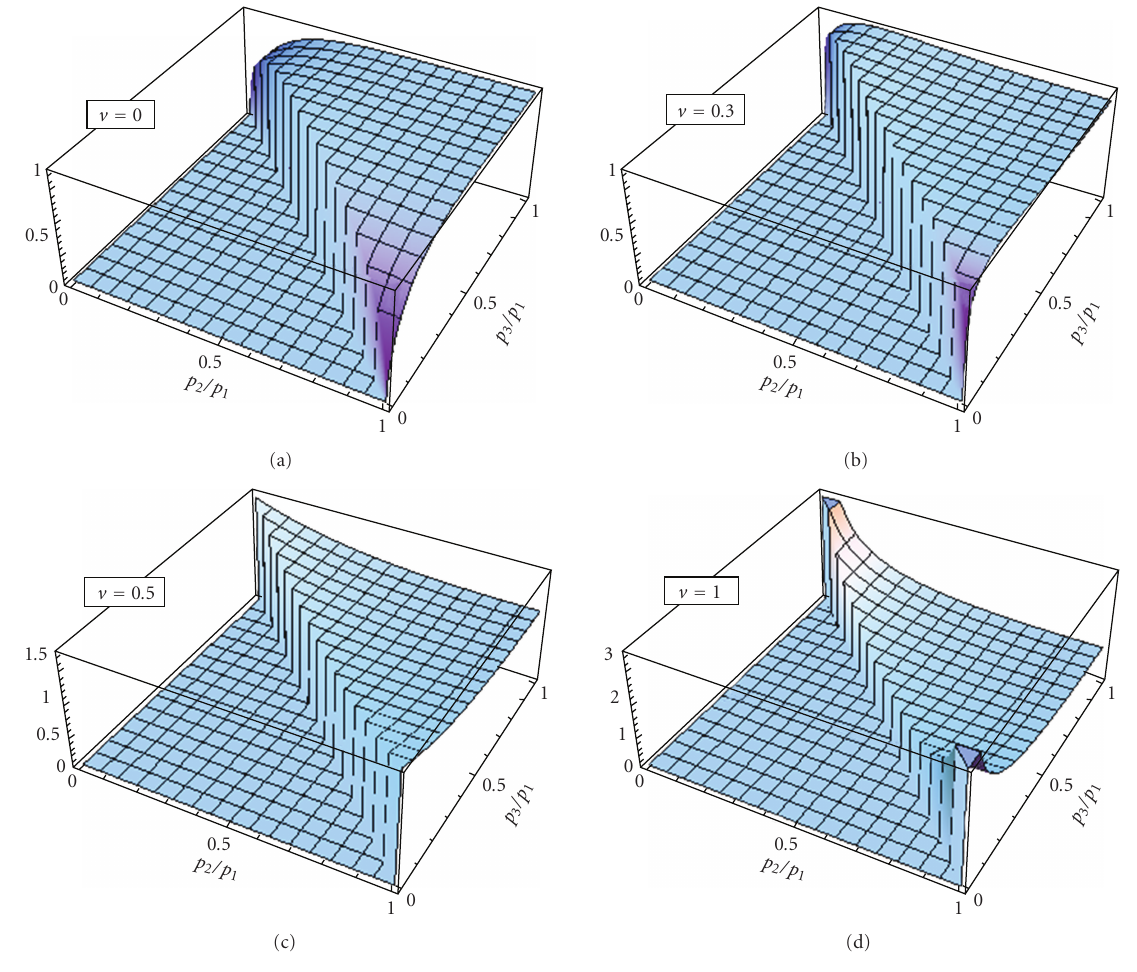
Figure 15: Shape ansatz (174) for the intermediate